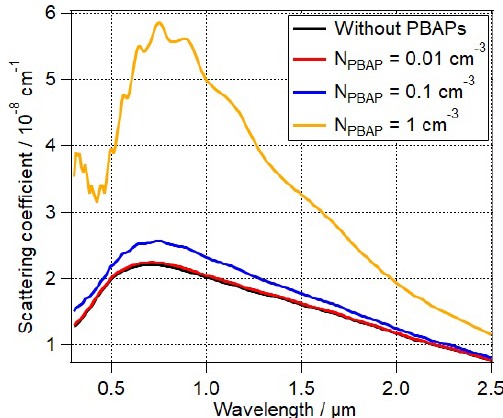
Figure 2. Total scattering coefficient for different PBAP number concentrations. The detailed input parameters can be found in Ta- ble 2. The black, red, blue, and brown lines correspond to S opt1 , S opt2 , S opt3 , and S opt4 in Table 2, respectively.